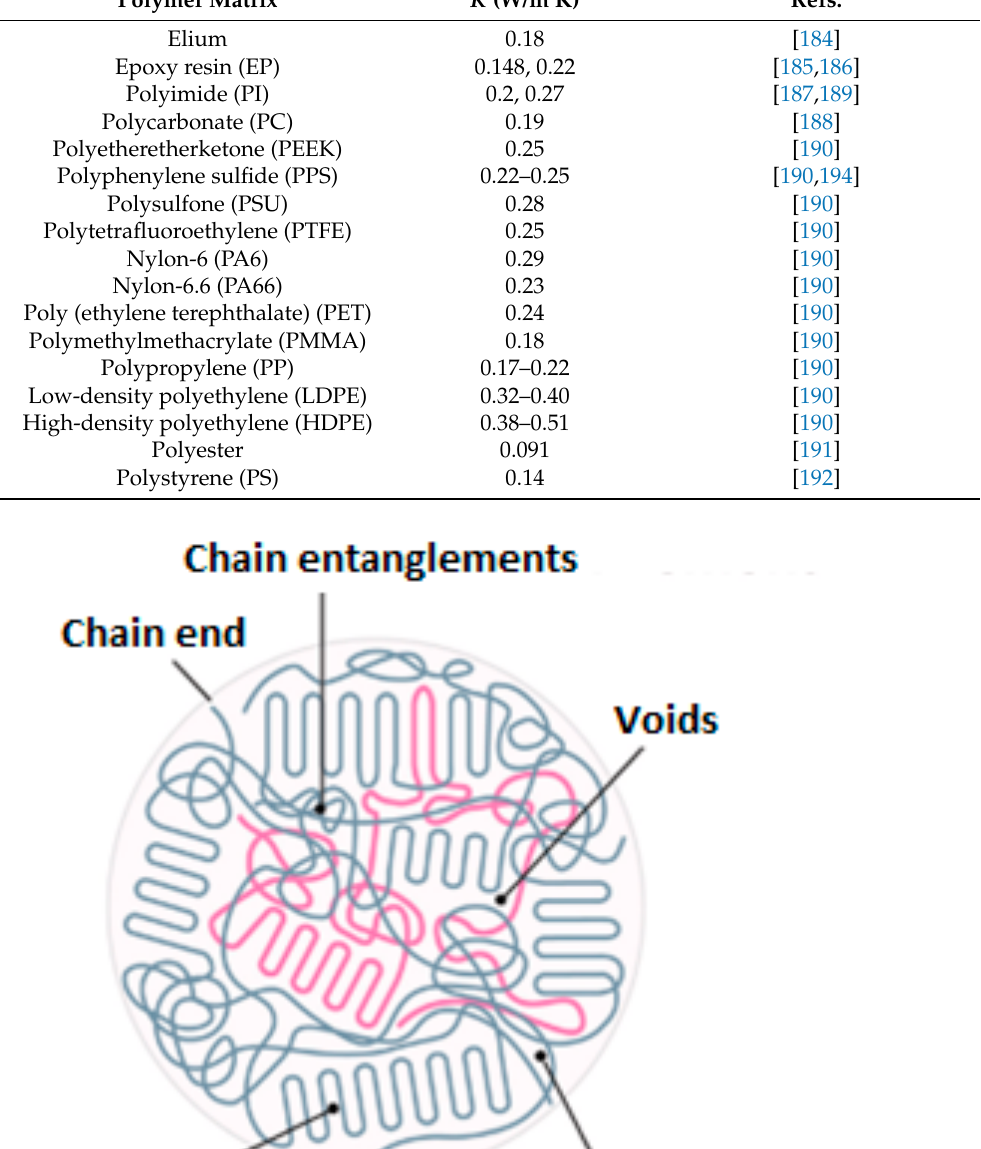
Figure 64. Schematic representation of the structural change of a PA 66 gear induced by self-heating effect during fatigue loading [193].